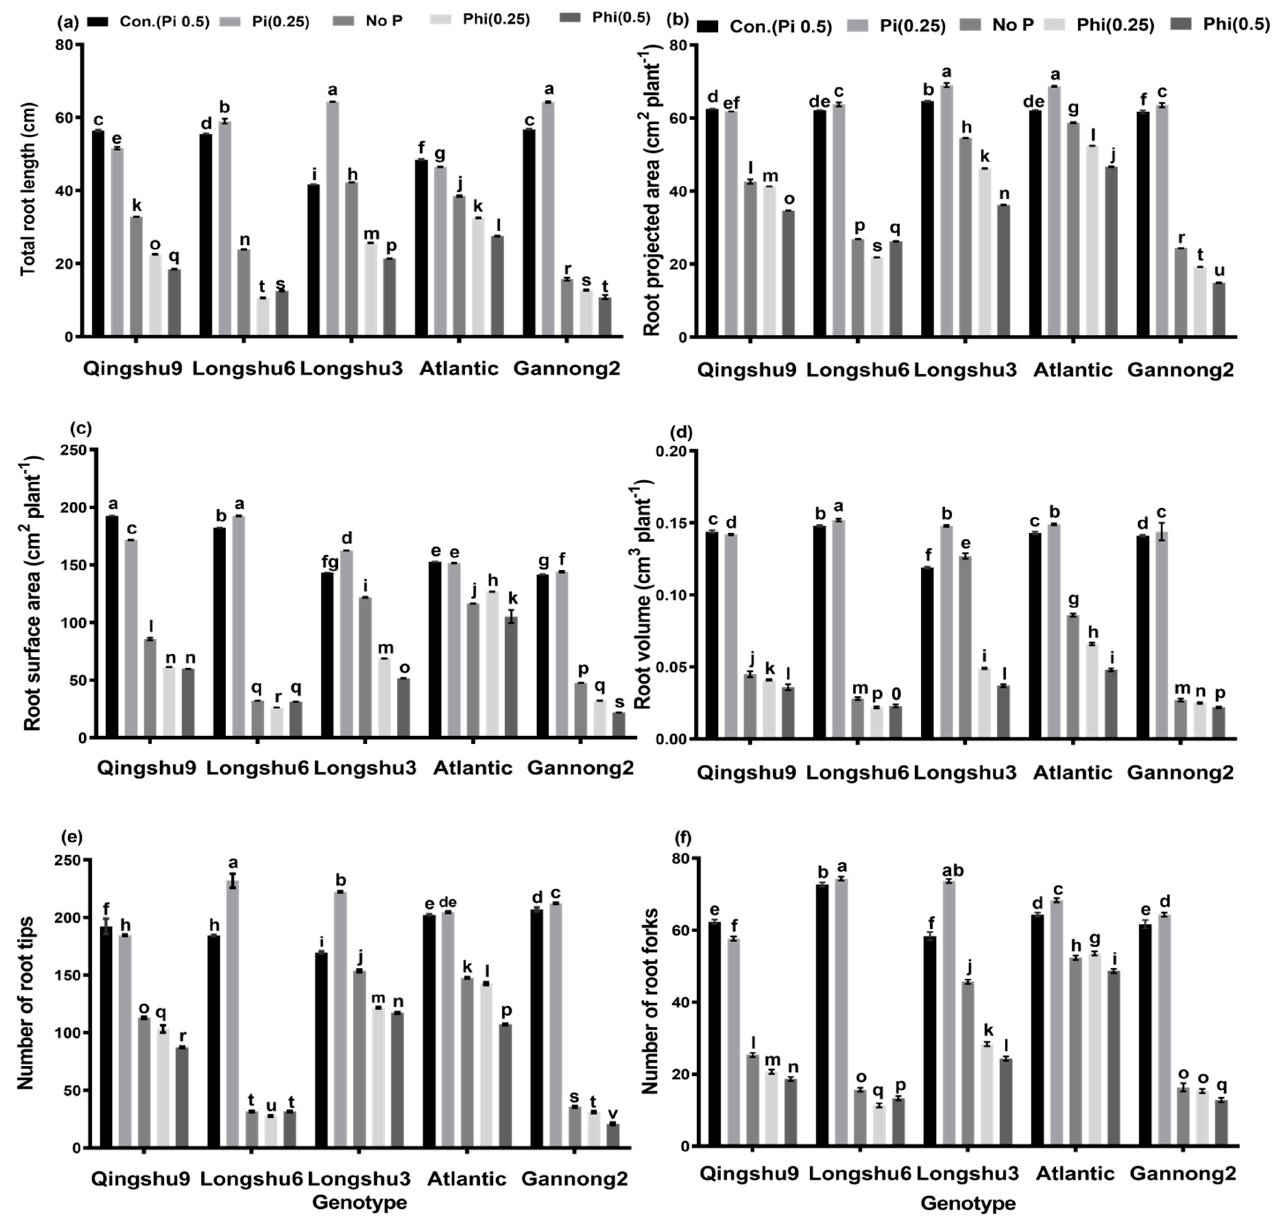
Figure 2. Effect of PO 3 , PO 4 and No-P on ( a ) Total root length ( b ) Root projected area ( c ) Root surface area ( d ) Root volume ( e ) Number of root tips and ( f ) Number of root forks of five potato genotypes grown for 20 days in medium containing concentrations of 0.25, 0.5 mM PO 3 and PO 4 and No-P. Values symbolize the mean of 3 replicates ± standard deviation (SD). Means followed by the same lowercase letter do not differ among treatments by Duncan Multiple range’s test ( p ≤ 0.05).